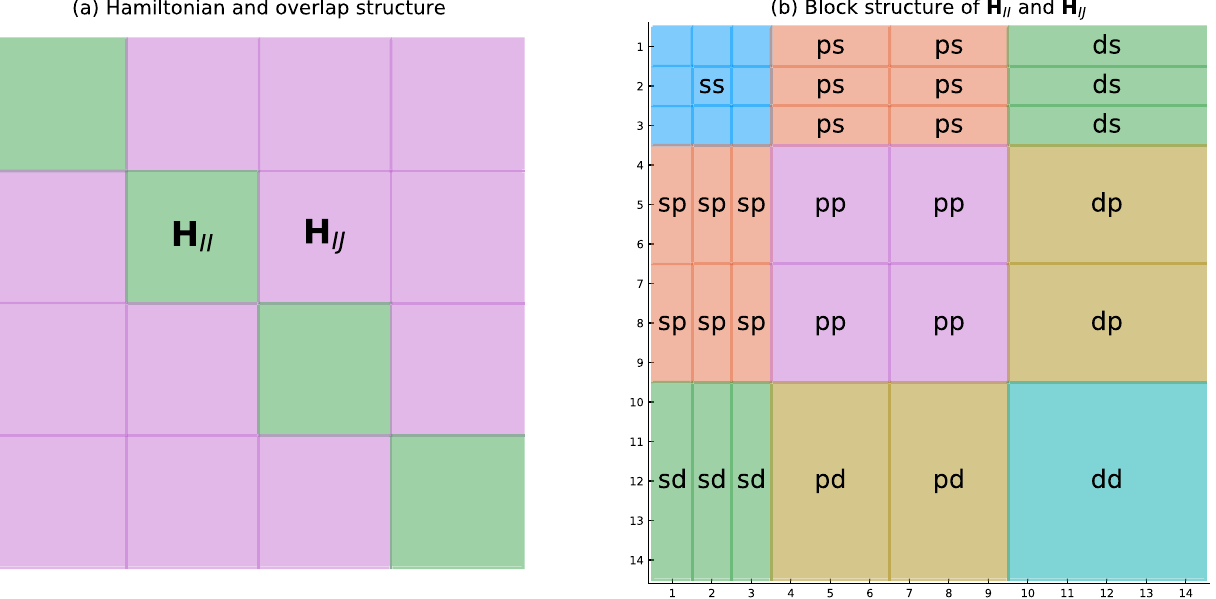
Fig. 2 Block structure and atomic orbital subblocks in the Hamiltonian and overlap matrices used in our models. Each block within panel a is a 14 × 14 matrix with the atomic orbital structure H IJ shown in panel ( b ). Blocks coloured green in a are onsite blocks, while those shown in purple are offsite blocks. Note that the onsite H II are self-adjoint and hence, e.g., only one of the ps and sp blocks needs to be fi